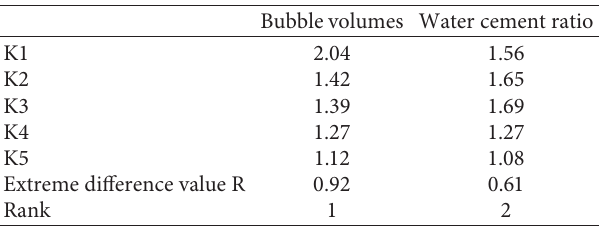
Table 10: Analysis of extreme differences in compressive strength of ordinary foam